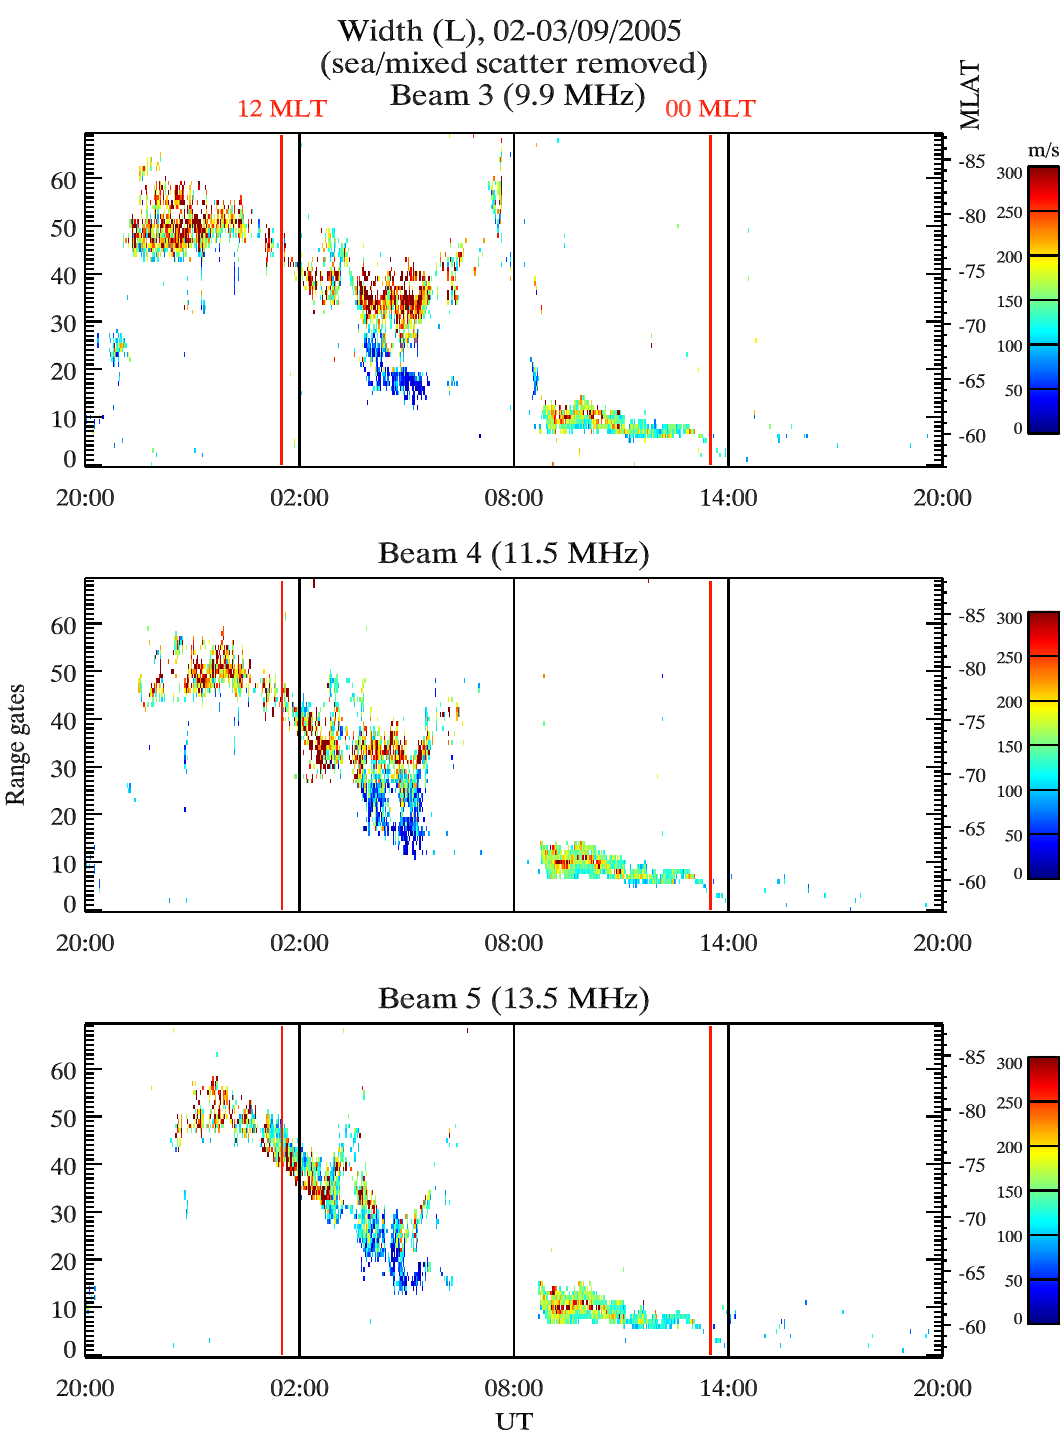
Fig. 7. The same as in Fig. 2 but with sea/mixed scatter removed (see text for details).